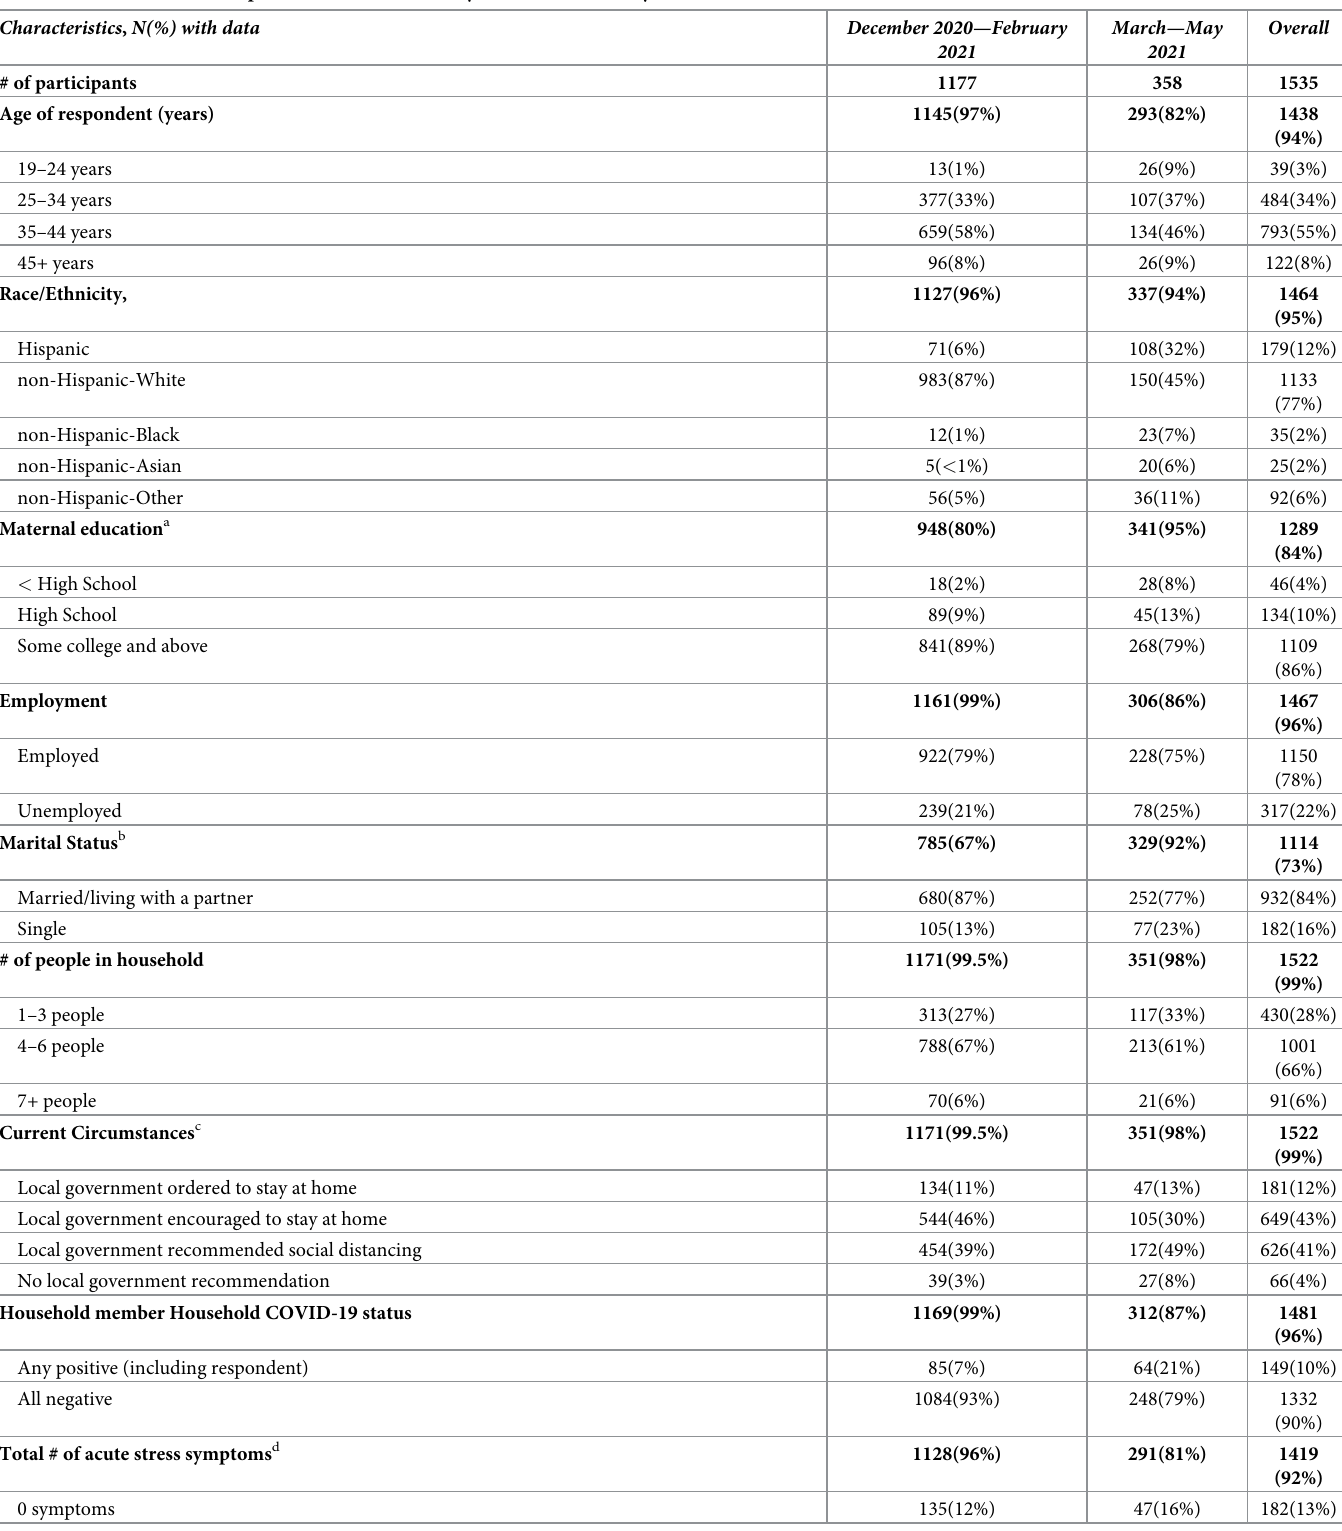
Table 1. Characteristics of respondents to the CEE survey December 2020-May 2021. Characteristics , N(%) with